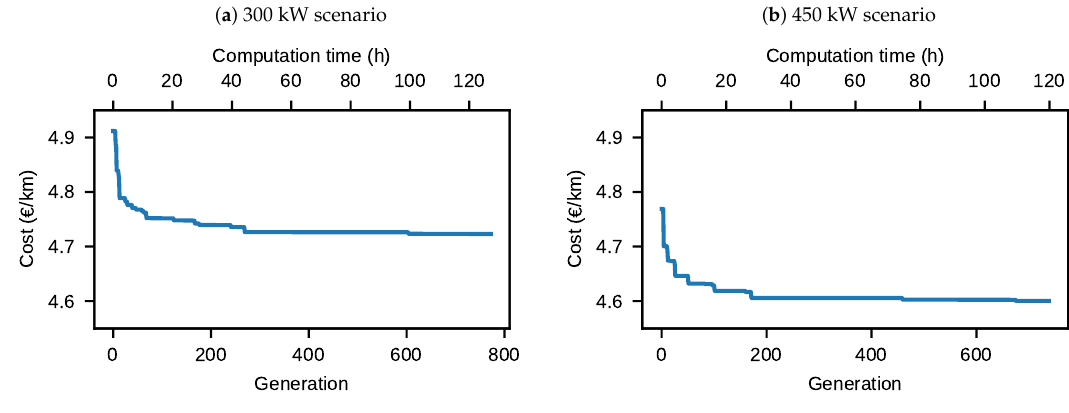
Figure 10. Progress of charging infrastructure